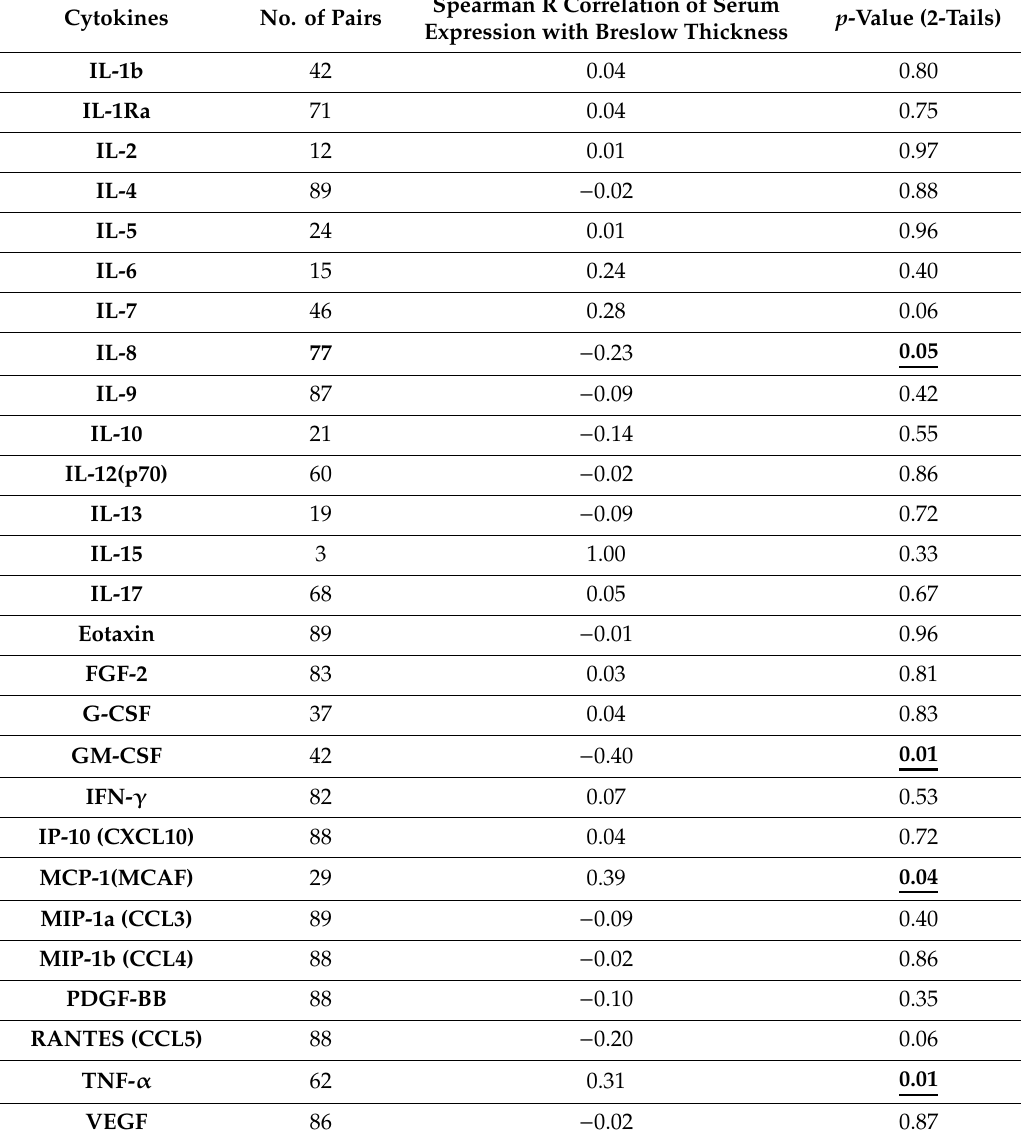
Bold underlined: highlight the